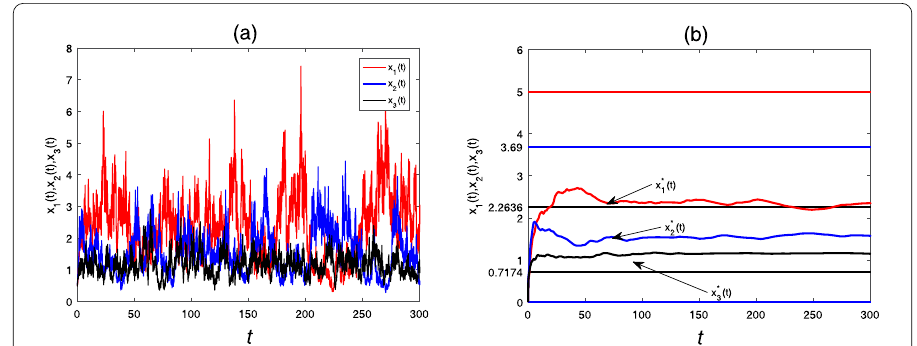
Figure 9 Persistence in the mean of system (2). (a) Time sequence diagram and (b) the phase portrait of system (2).( x 1 (0), x 2 (0), x 3 (0)) = (0.5,0.5,0.5), σ 2 1 ( t ) = σ 2 2 ( t ) = σ 2 3 ( t ) = 0.1 + 0.04sin